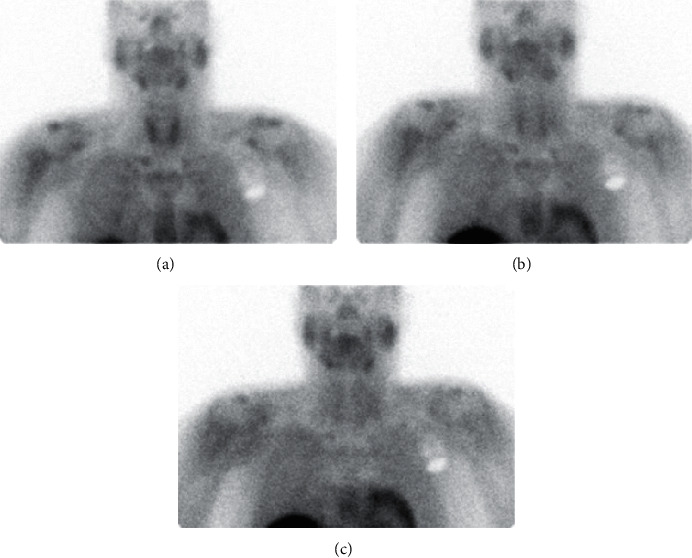
The 99m-STS with a dose of 19.4 mCi showed intense initial intense uptake of the tracer activity within the thyroid parenchyma followed by bilateral symmetrical gradual washout of tracer activity in the 1-hour and 2-hour delayed images suggestive of AIT-1. (a) 15 min delay; (b) 1 hr delay; (c) 2 hr delay.